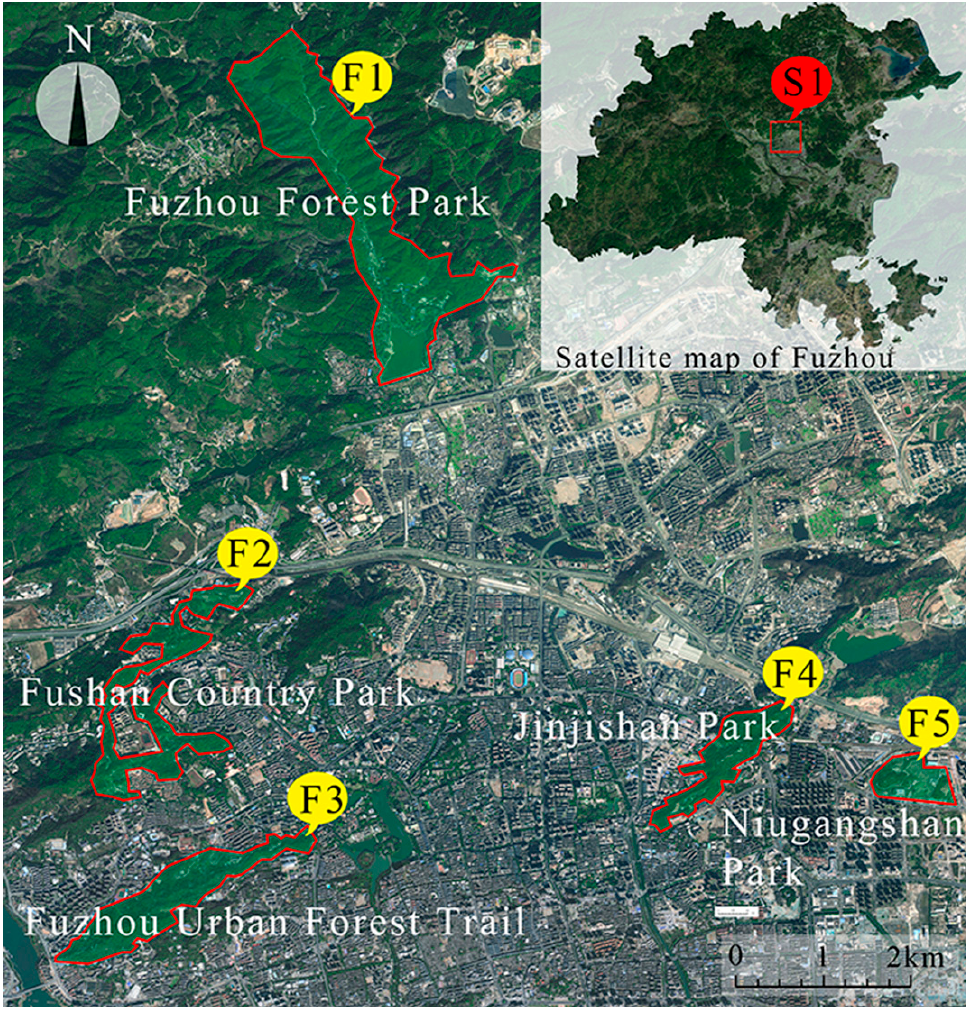
Figure 1. Locations of 5 Urban Forest Recreation Areas in the main city of Fuzhou: S1, the location of the main city of Fuzhou; F1, Fuzhou Forest Park; F2, Fushan Country Park; F3, Fuzhou Urban Forest Trail; F4, Jinjishan Park; F5, Niugangshan Park.